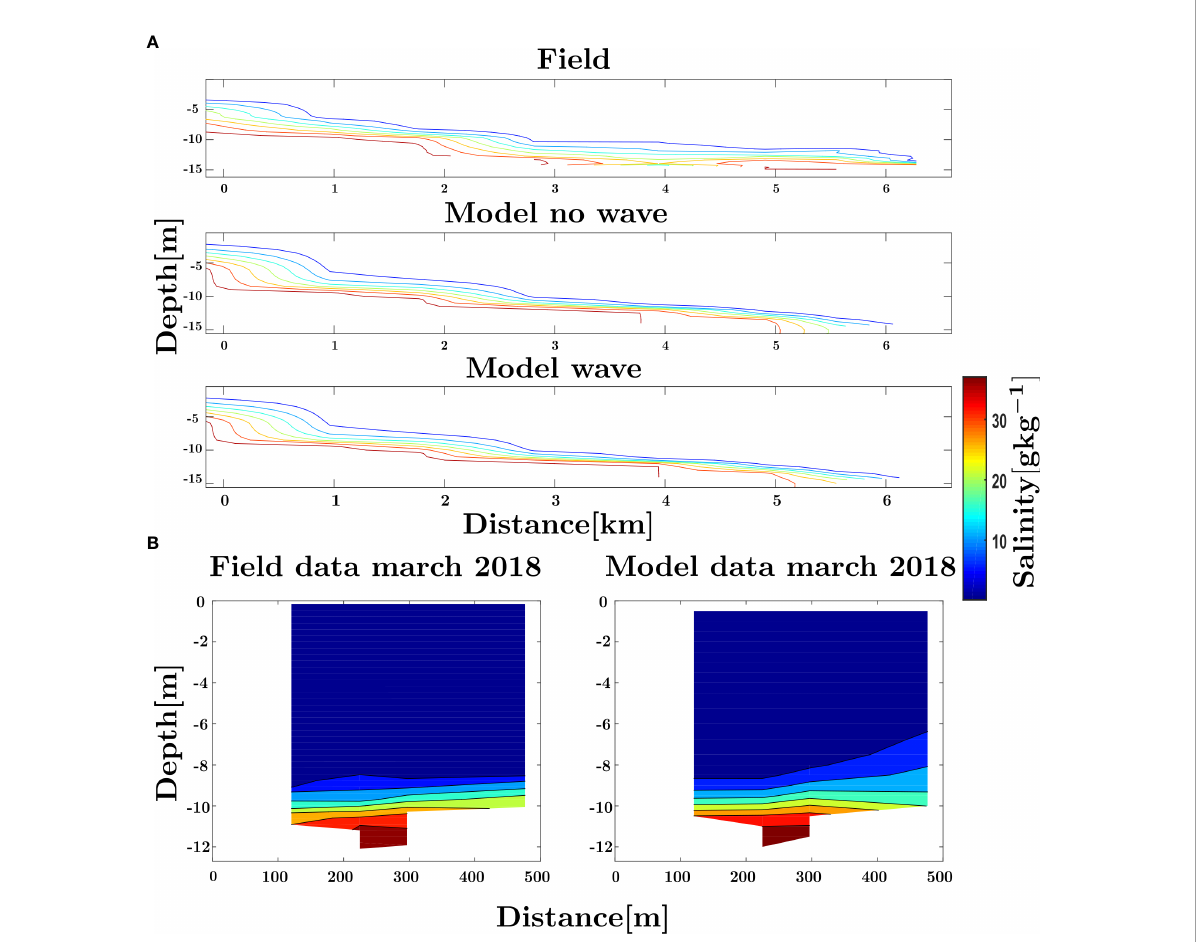
FIGURE 3 Measured and modeled salinity transects in the inner estuary in March 2018. (A) Longitudinal transect. (B) Transversal transect at km 2 inside the estuary.